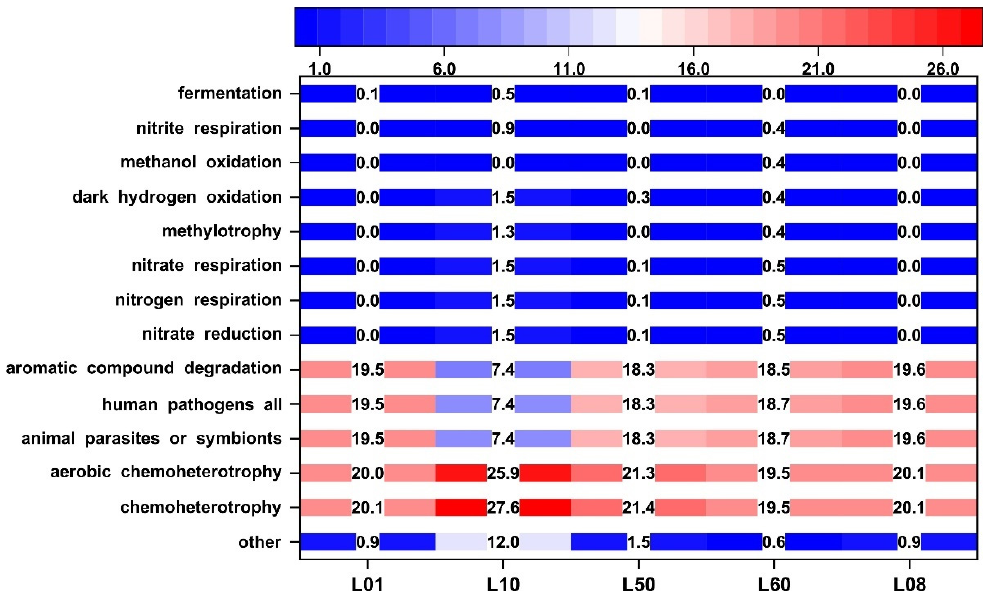
Figure 4. Heat map illustrating function prediction of bacterial community. The numbers are the abundance of the functions in %.